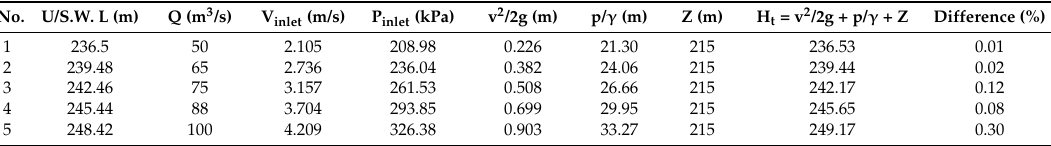
Table 6. Total head with the difference of error calculation at the inlet of the Temenggor turbine unit. No. U/S.W. L